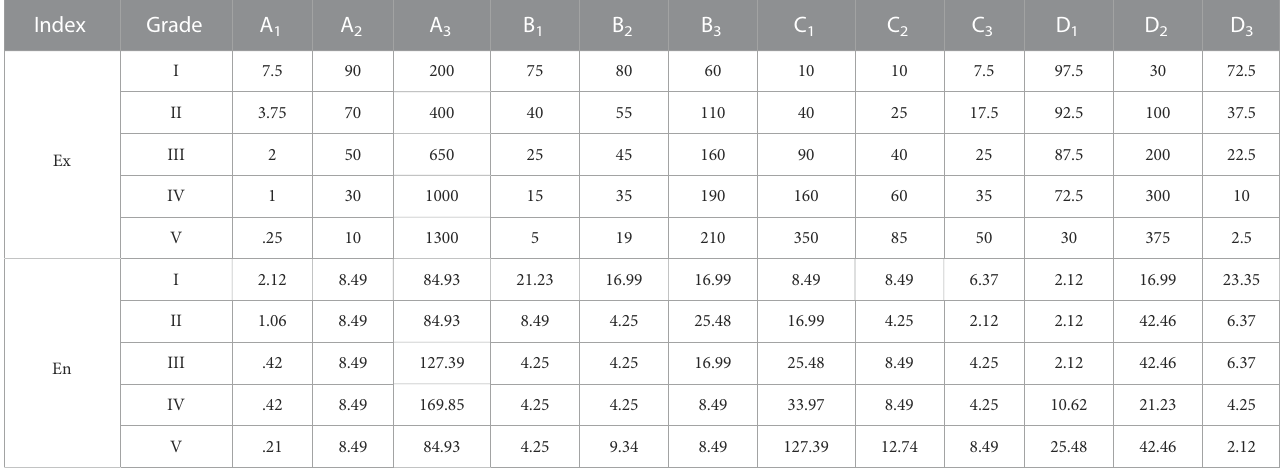
TABLE 12 The digital characteristics of the cloud.